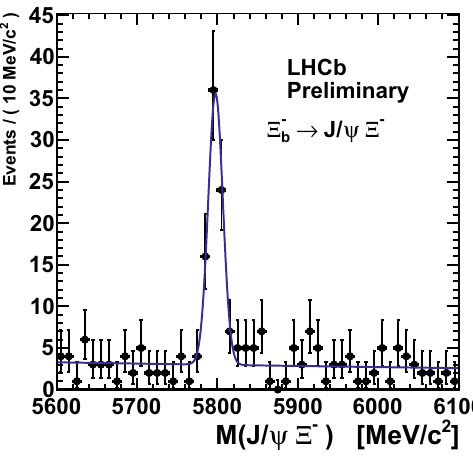
Figure 11. Ξ − b candidates invariant mass